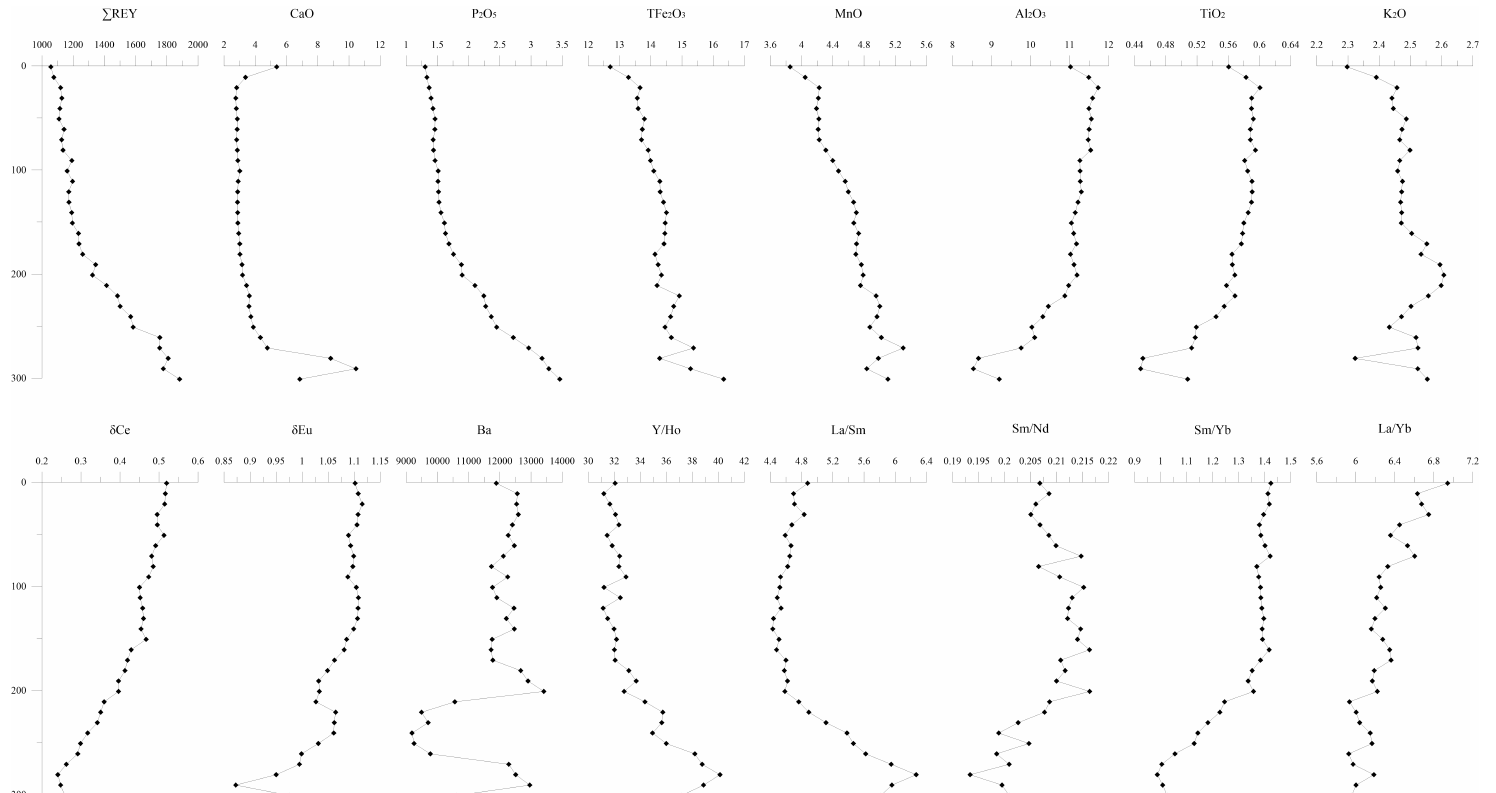
Figure 5. Profiles of REY content and other characteristic parameters of the bulk sediment samples from core